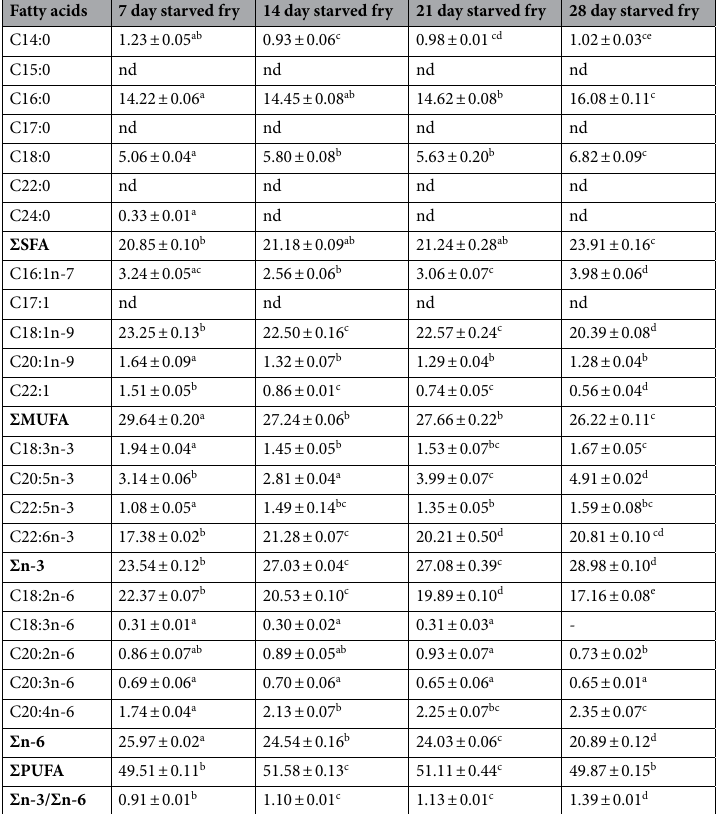
Table 7. Fatty acid composition of starved fry of Oncorhynchus mykiss .* *The meaning of the symbols is given under Table